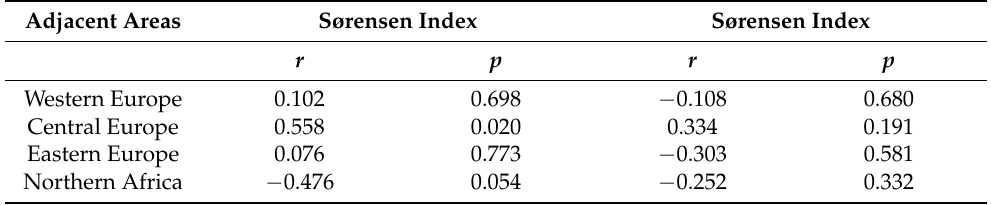
Figure 4. Spatial variations in the Simpson index of similarity between Italian regions and adjacent ma- jor areas for earwigs: ( a ) Western Europe; ( b ) Central Europe; ( c ) Eastern Europe; ( d ) Northern Africa. Table 3. Correlation (Pearson coefficient) between latitude and biogeographical similarities of Italian regions with adjacent areas expressed by Sørensen and Simpson